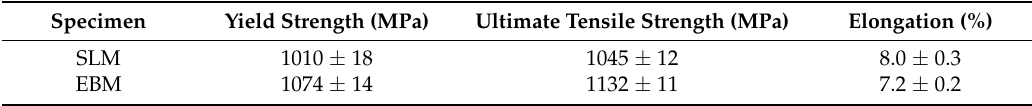
Table 2. Comparison of tensile properties between SLM and